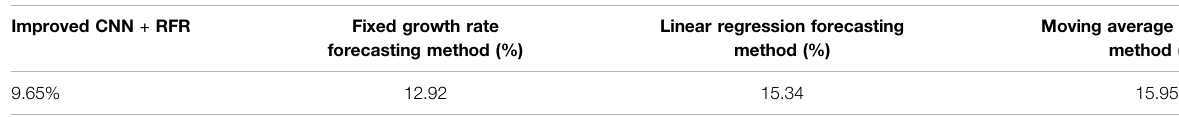
TABLE 5 | The median error of different methods.